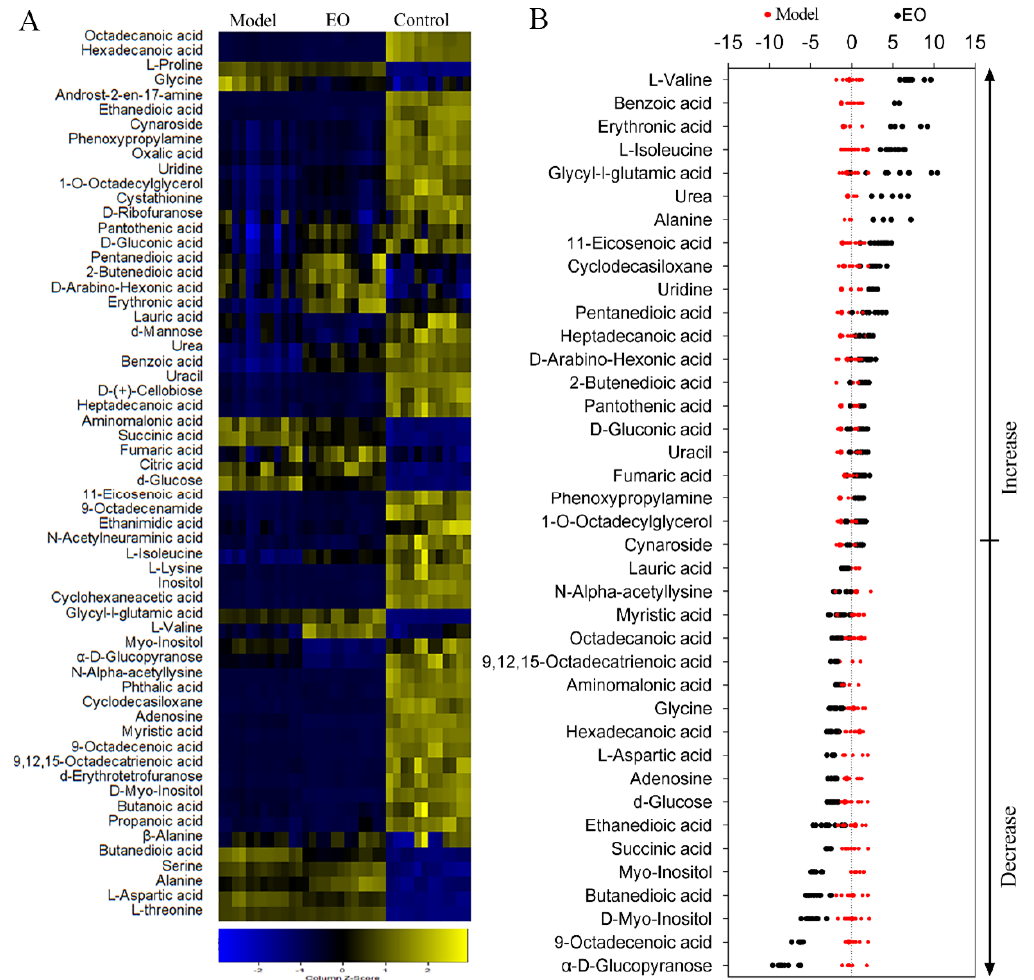
Figure 2. Metabolic profiles of BV2 microglial cells in response to EO. ( A ) Heat maps of metabolites (row). Yellow and blue indicate an increase and decrease of the metabolites relative to the mean and standard deviation of the row metabolite level, respectively (see color scale). ( B ) Z-score scatter diagrams of significant differentially expressed metabolites ( p < 0.05) in the presence or absence of EO. Metabolites are showed on the y-axis.